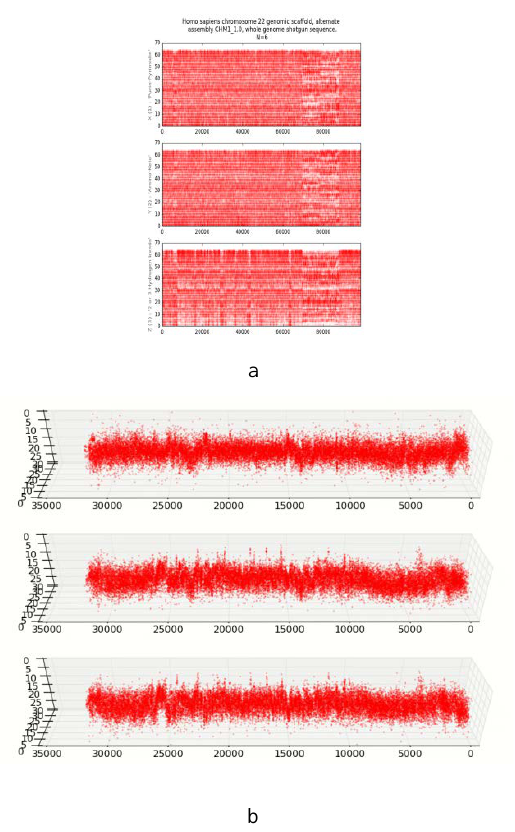
Fig. 4. a - visualization of the three-channel representation of the nucleotide composition of the fragment of the 1st chromosome of the apple. Each of the three rows (a) corresponds to a binary oppositional sub-alphabet. The abscissa axis encodes the sequence number of the N-plet, the ordinate axis encodes the number of units in the N-plet. The differences in the nucleotide composition for each of the subalphabets are clearly visible . b - 3-d visualization of integral three-channel representation of the nucleotide composition of a fragment of the 22nd chromosome of Homo Sapiens. Each of the three rows (b) corresponds to a pair of binary oppositional sub-